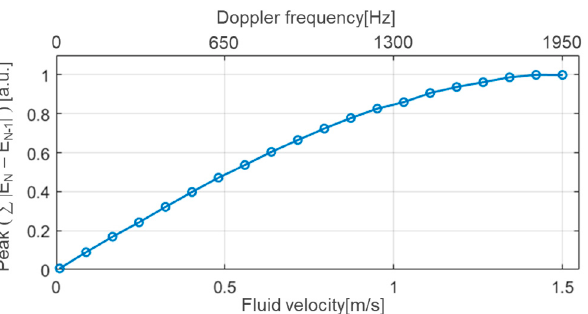
Figure 10. Numerical simulation result of peak value of accumulated ensemble difference with re- spect to fluid velocity under the following conditions: PRF of 4 kHz, carrier frequency of 2 MHz, and a Doppler angle of 60°.